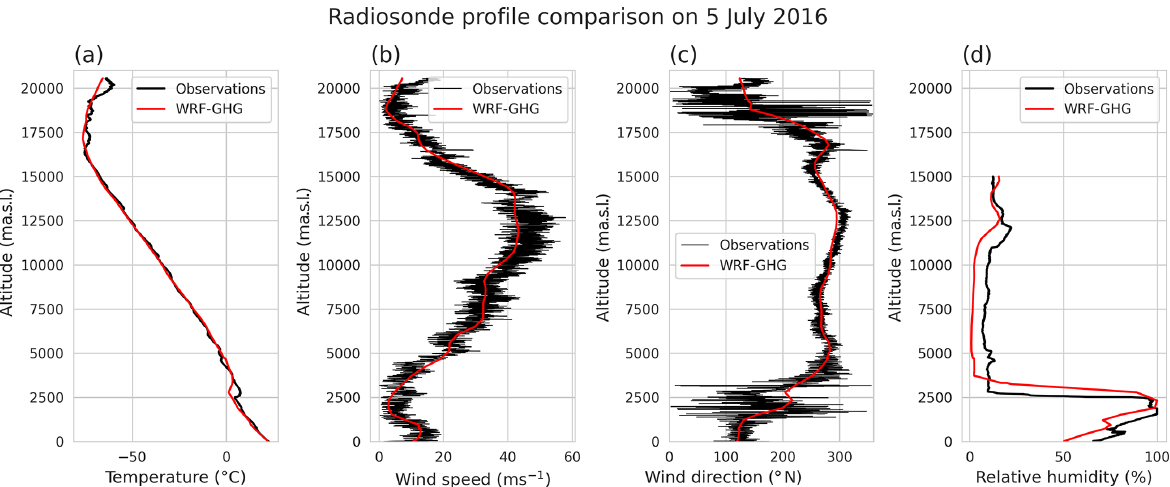
Figure 5. Example of the radiosonde data at Roland Garros Airport on 5 July 2016, compared with the model for (a) temperature, (b) wind speed, (c) wind direction, and (d) relative humidity. The black line represents the measured values. The red line is the corresponding WRF- GHG